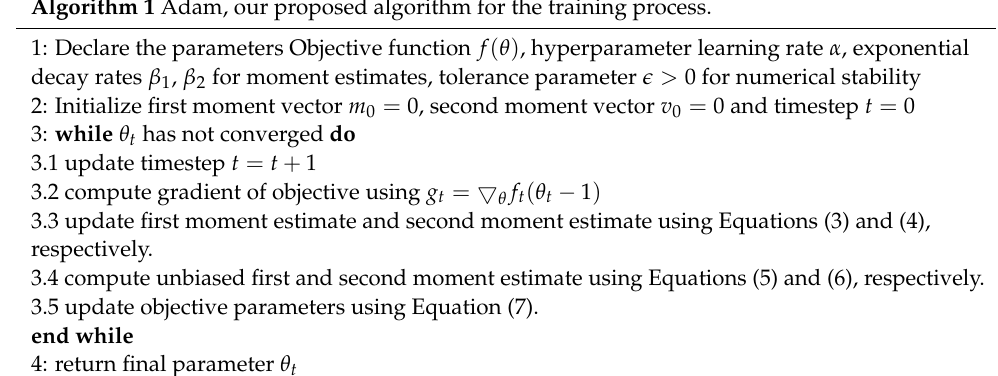
Algorithm 1 Adam, our proposed algorithm for the training